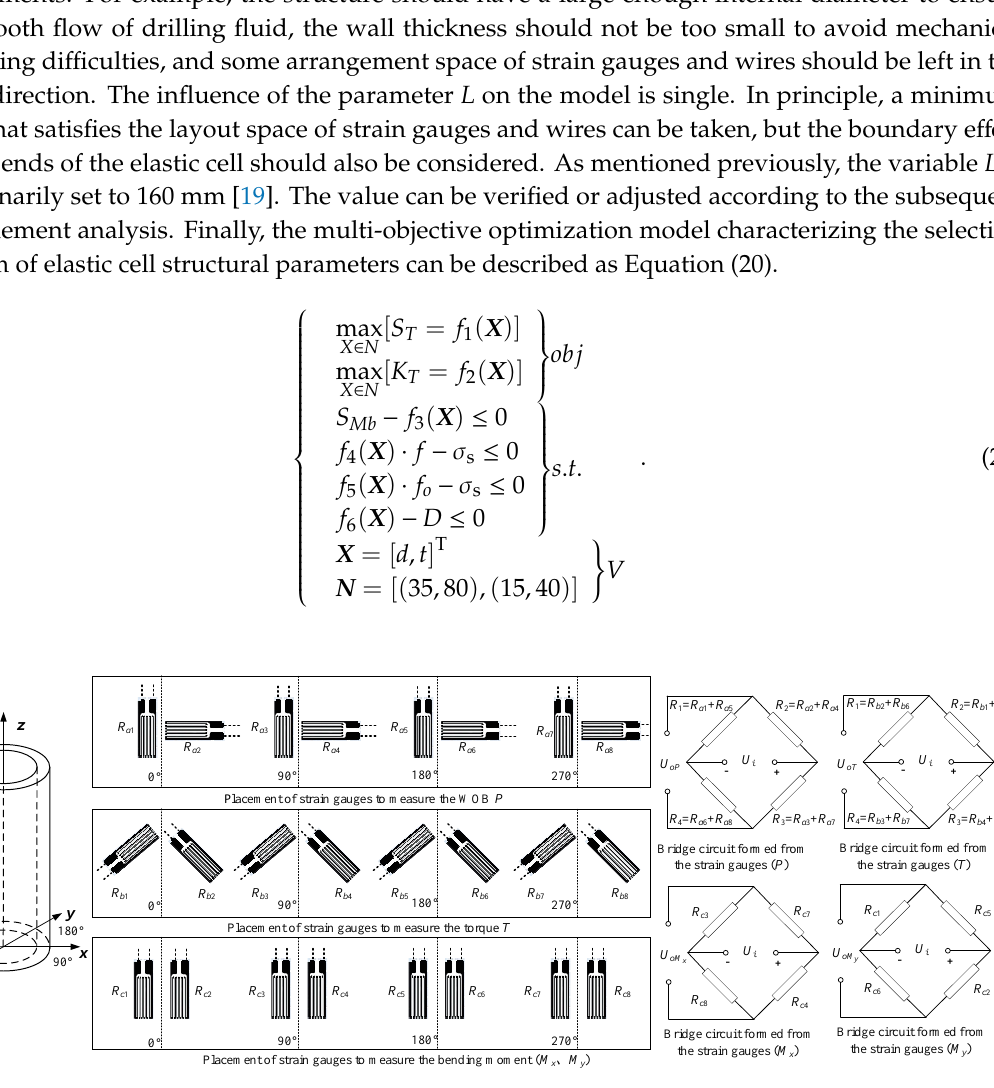
Figure 5. Placement and bridge schemes of strain gauges.